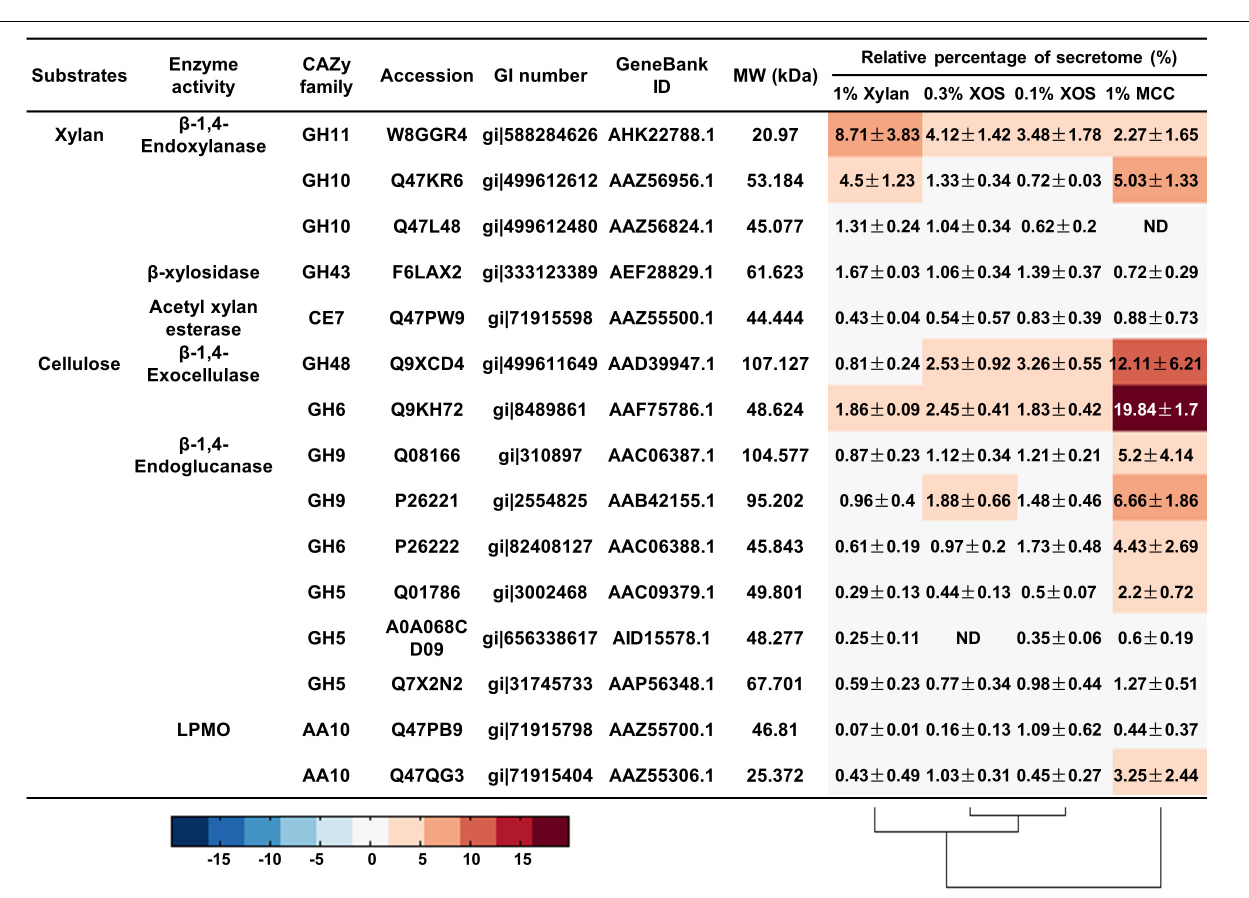
FIGURE 6 | The relative quantities of xylan- and cellulose-degrading proteins in the secretome of T. fusca grown on different carbon sources. MCC, microcrystalline cellulose; XOS, xylo-oligosaccharide; ND, not detectable.